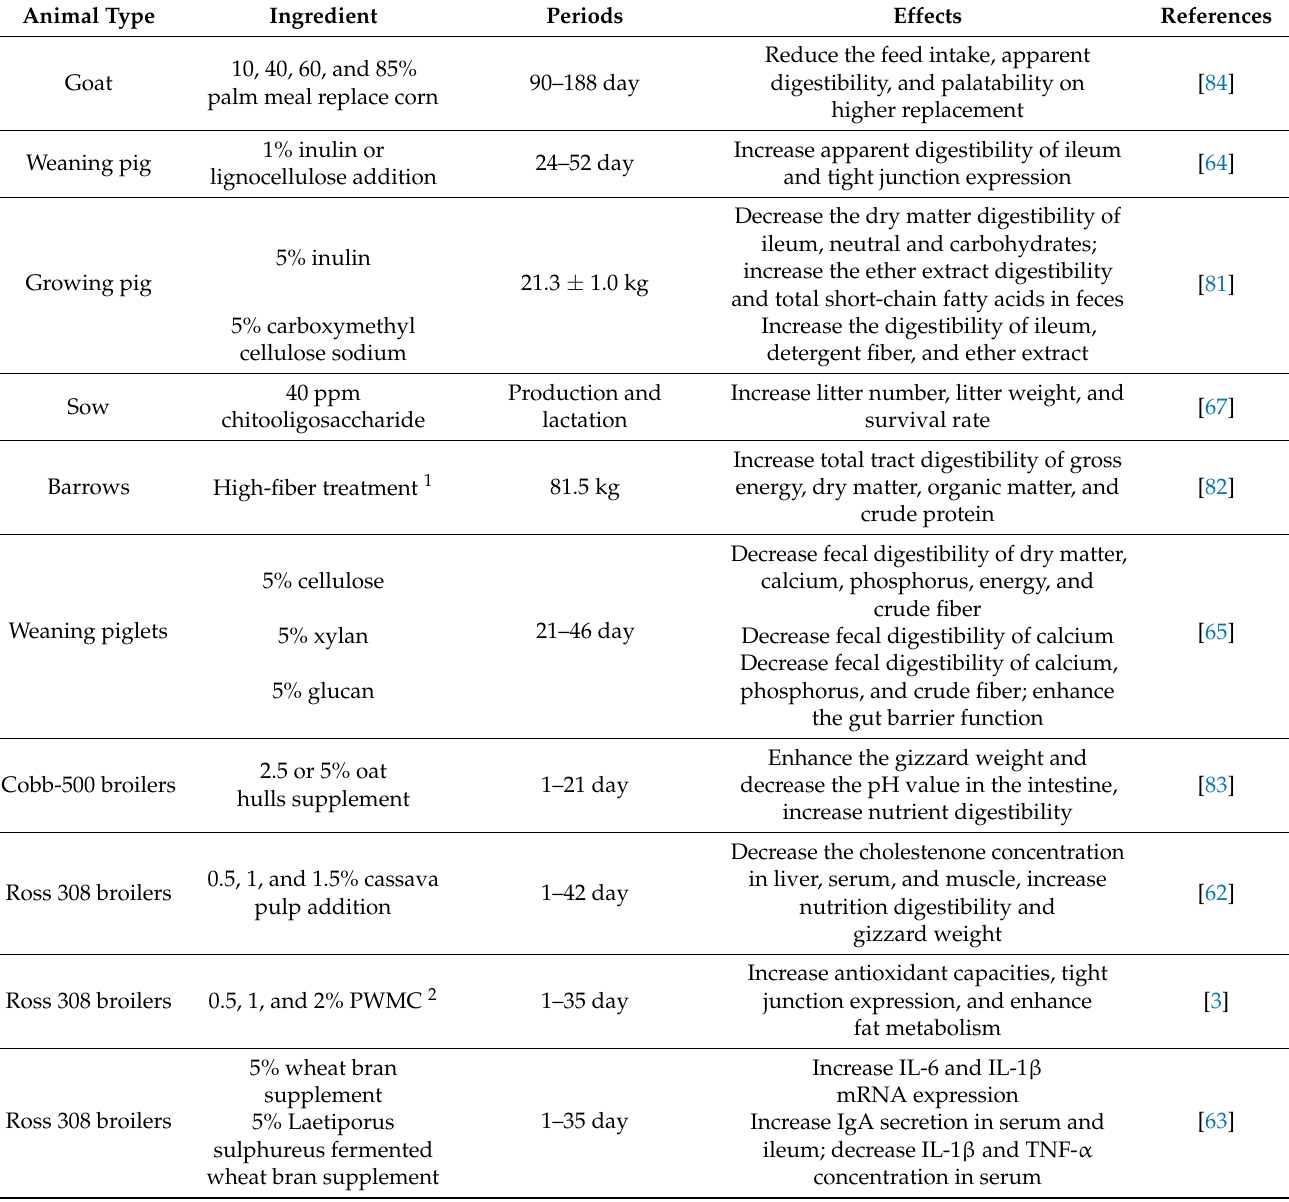
Table 2. Effect of fiber supplements on digestibility, health, and animal production